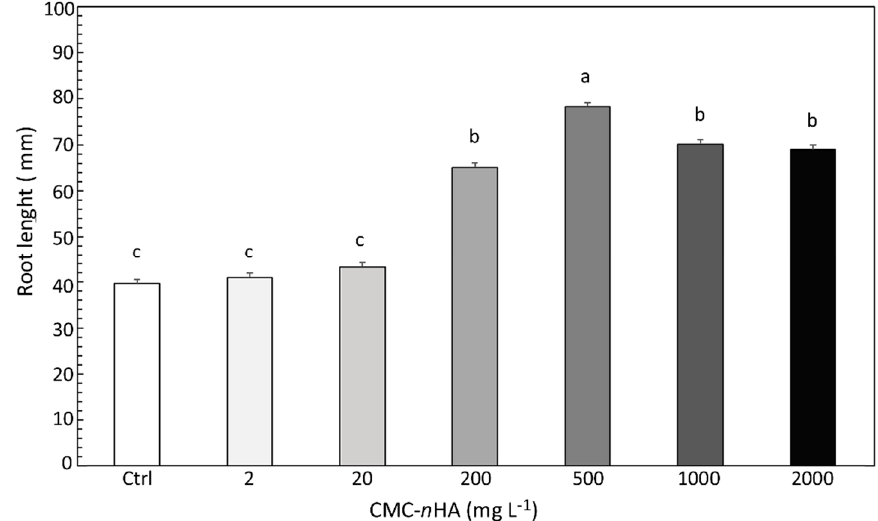
Figure 6. Effect of CMC- n HA on primary root elongation of S. lycopersicum . Bars represent the mean standard deviation. Different letters indicate statistically significant differences between treatments (LSD test, p ≤ 0.05).